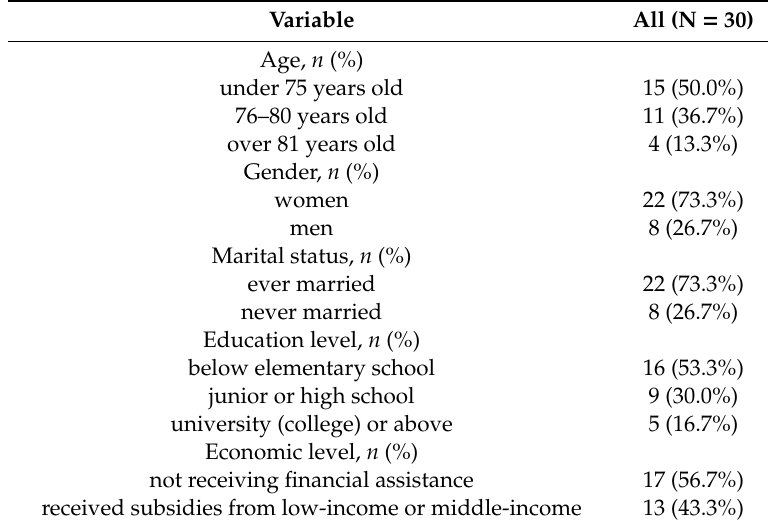
Table 2. Characteristics of the